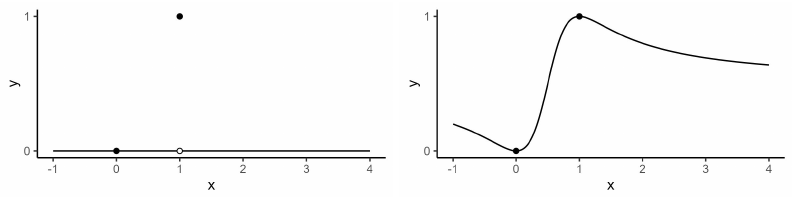
Figure 4. Minimizing average slope extension for p = 2 of the function f ( 0 ) = 0, f ( 1 ) = 1 for different measures. In the fist one, µ = δ 0 , and in the second one, µ = 1